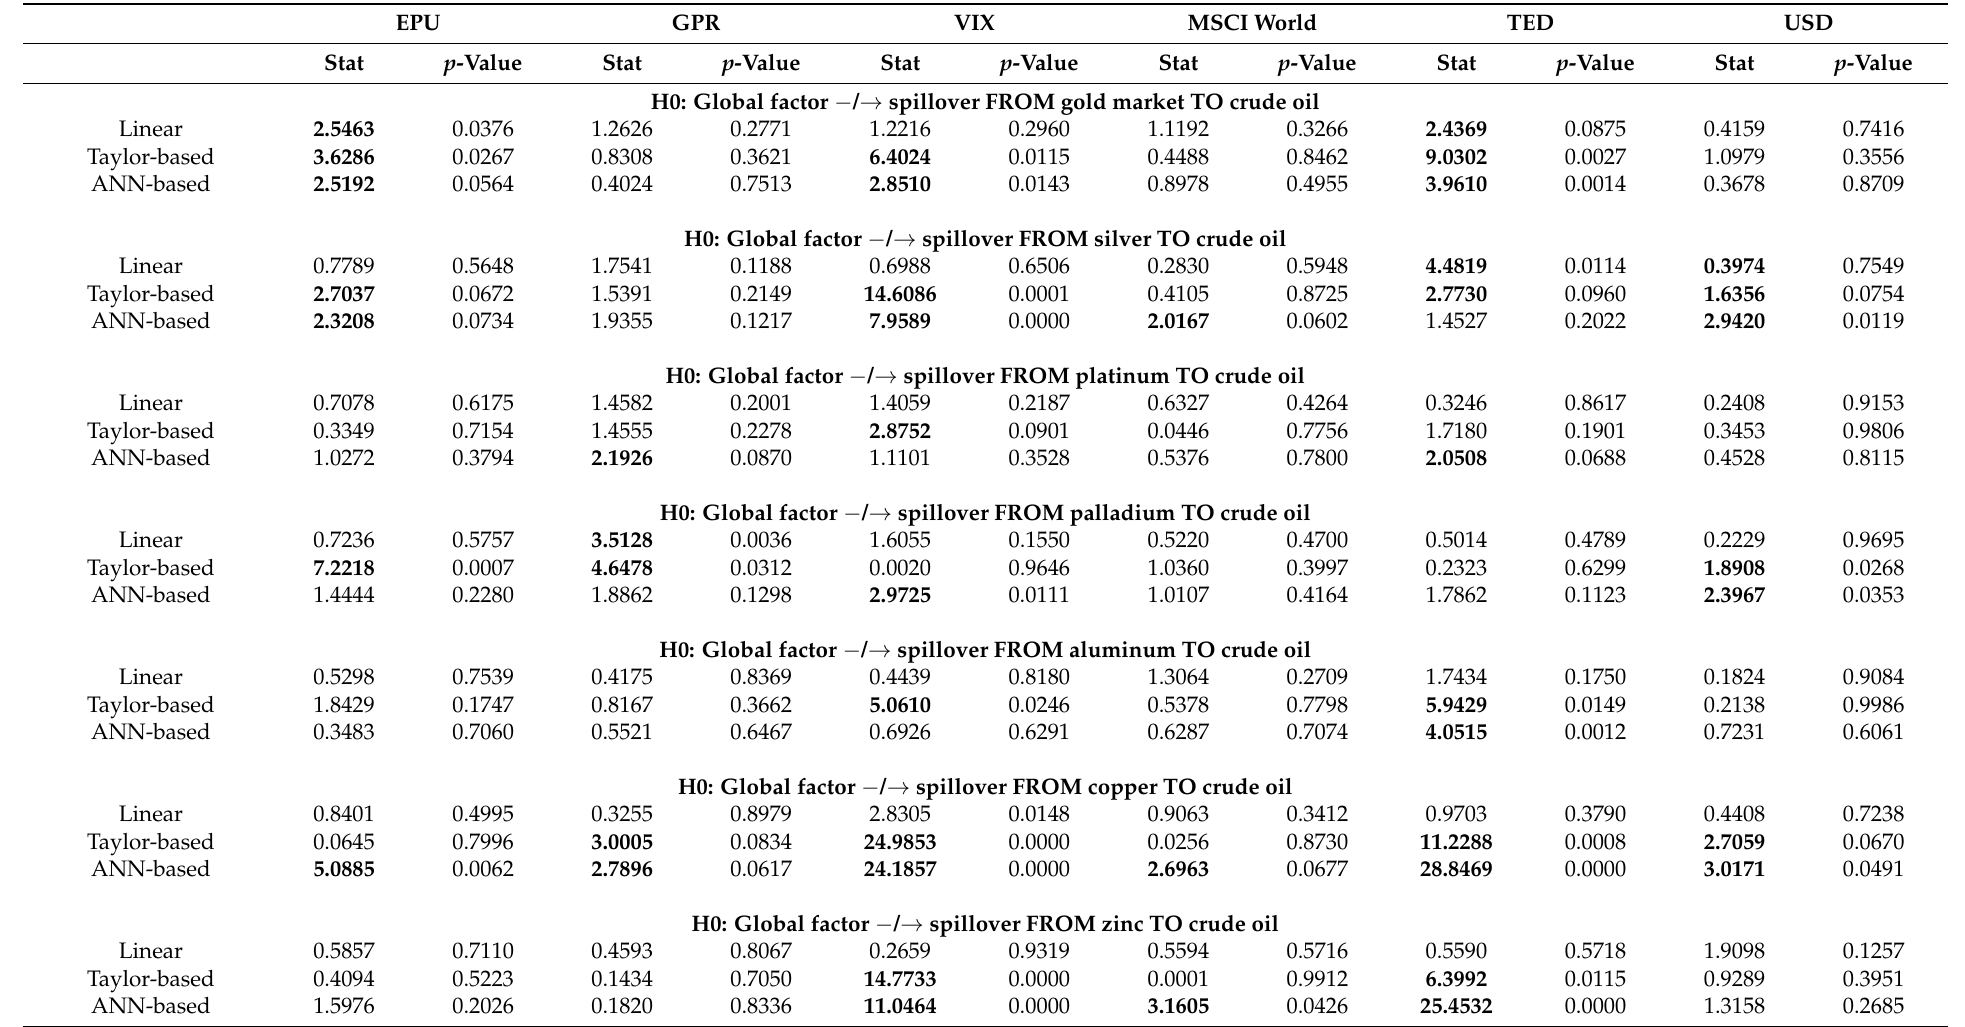
Table 6. Linear and nonlinear causality tests for spillovers from individual commodity uncertainties to oil (full